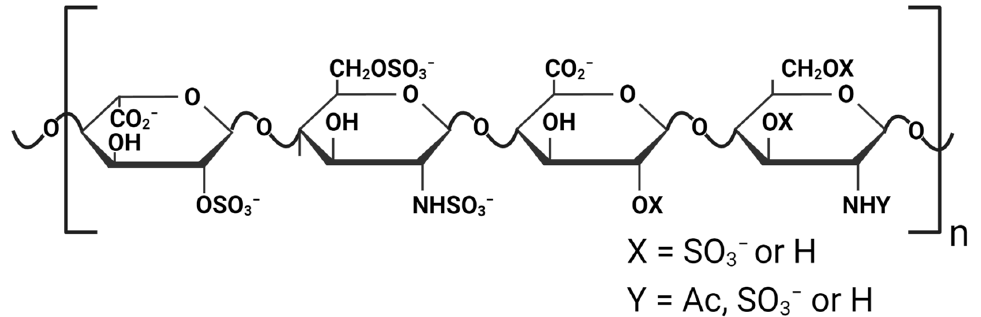
Scheme 1. Chemical structure of heparin is shown as an example by two disaccharide units: the left disaccharide unit composed of 2-O-sulfated iduronic acid and 2-N- and 6-O-sulfated glucosamine, and the right disaccharide unit composed of glucuronic acid (with or without 2-O-sulfation) and glucosamine (with or without 2-N-acetylation or sulfation or 6-O-sulfation). Created with Biorender.com.